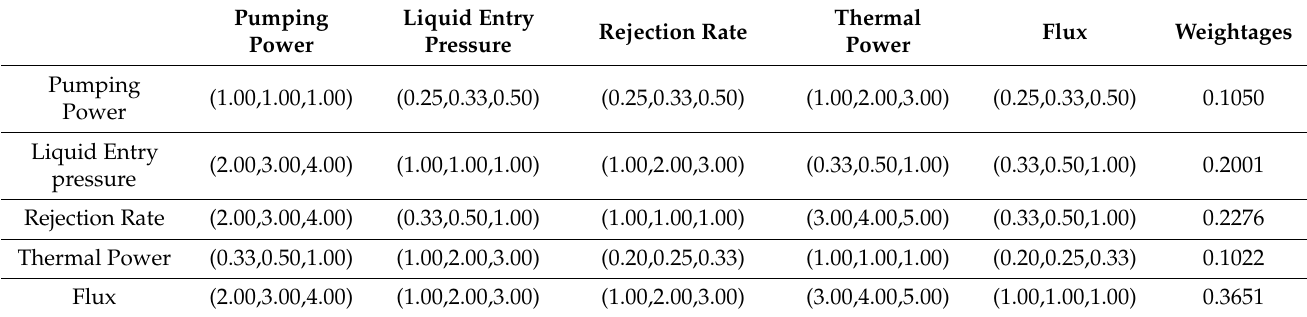
Table 7. Pairwise comparison of derivable outputs of MD using Fuzzy-AHP.